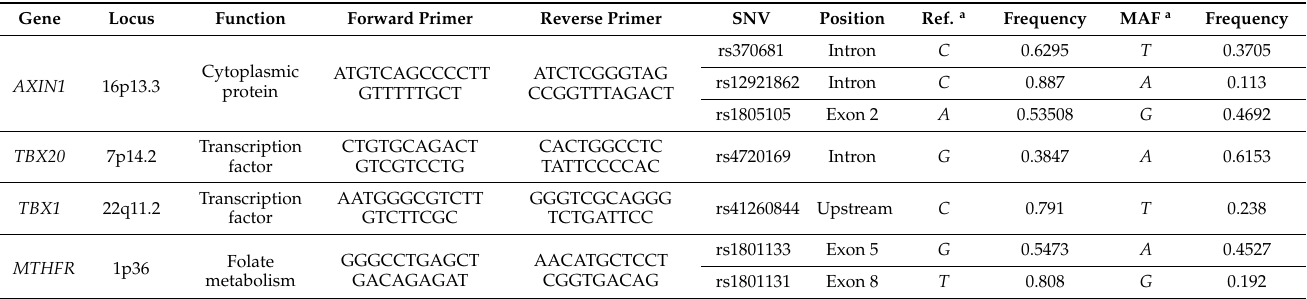
Table 2. Selected single nucleotide variants.